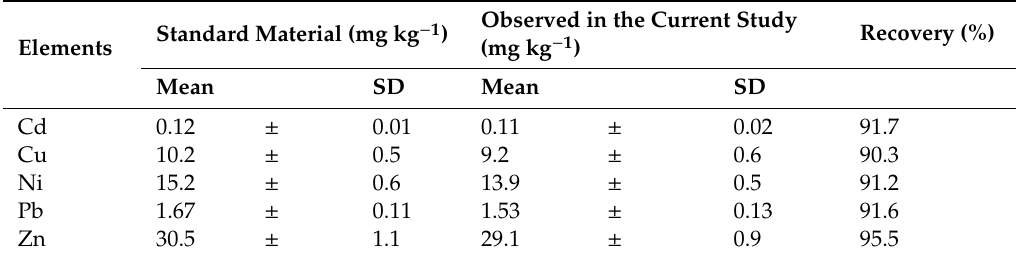
Table 2. Recovery rates for the standard material used in the current study.